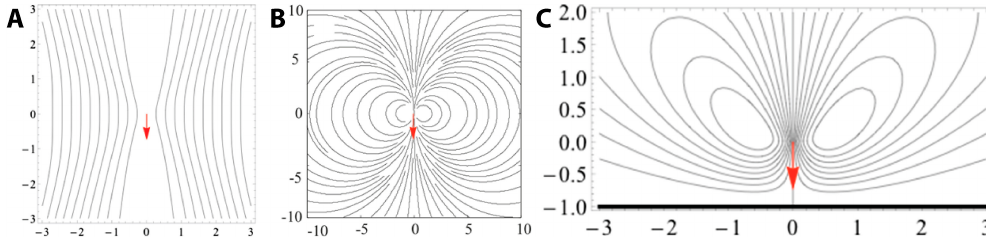
Figure 5. Streamlines around a stokeslet in various geometries. The red arrow represents the direction of the stokeslet force and thus the orientation of the Vorticella zooid axis (arrow points from the peristome to the scopula). ( A ) Stokeslet in free space; ( B ) stokeslet between two parallel planes (reproduced from [8]); ( C ) stokeslet pointing perpendicular to a single plane boundary, which is indicated by the bold black line.